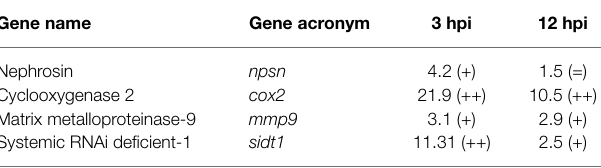
TABLE 4 | Early diagnosis of fish vibriosis due to V. vulnificus by RT-qPCR.